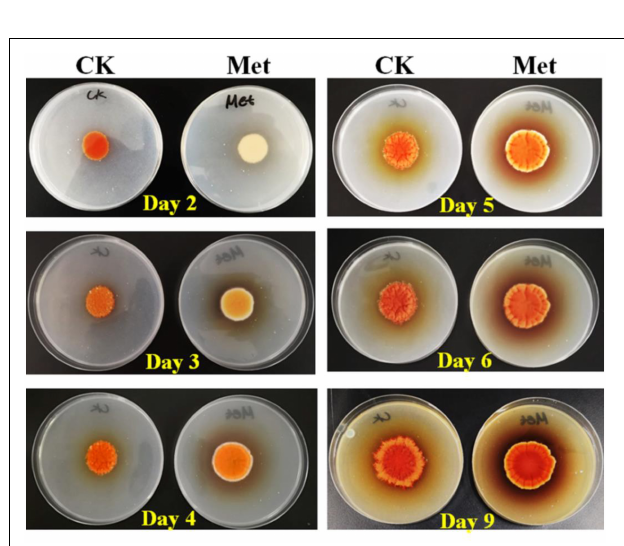
FIGURE 1 | Monascus pigments (MPs) production in Monascus purpureus RP2. CK, fermentation without addition of methionine; Met, fermentation with addition of 3 g/L methionine.